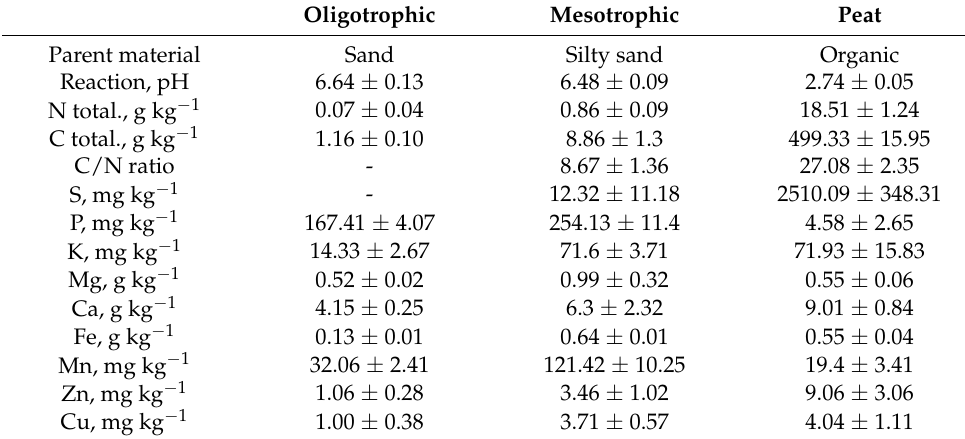
Table 1. Detailed characteristics of the studied soil substrates. Oligotrophic Mesotrophic Peat Parent material Sand Silty sand